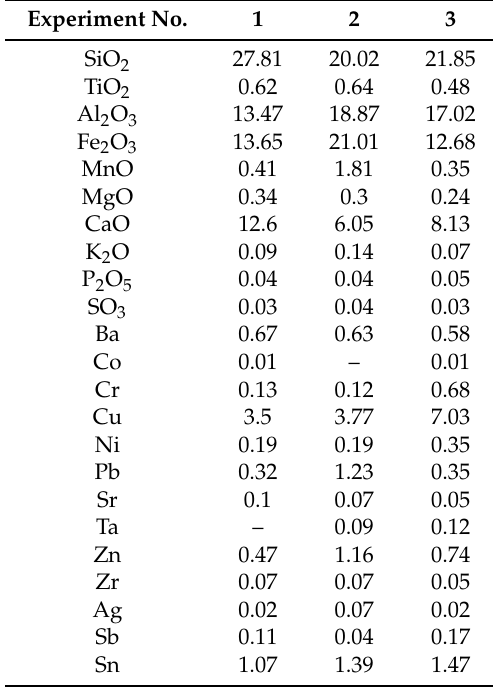
Table 6. X-ray fluorescence (XRF) analysis of slag samples from printed circuit boards processed in plasmatron plasma